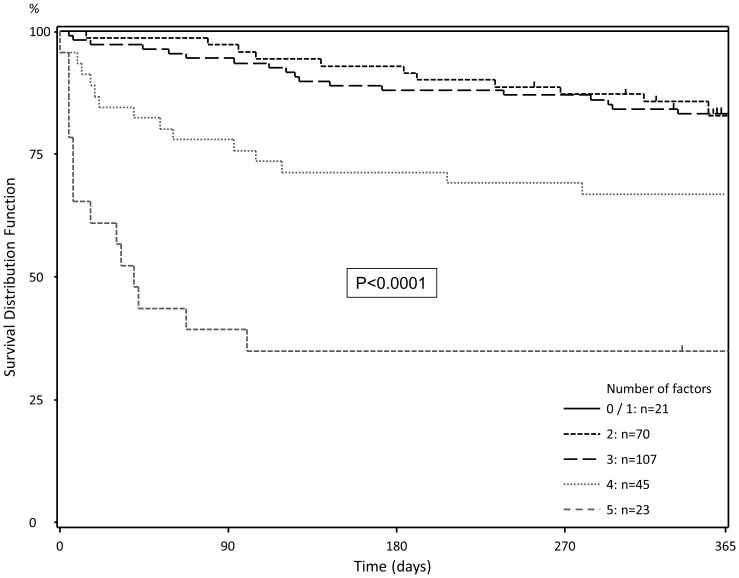
Survival stratified for number of positive risk factors.With an increasing number of risk-factors, postoperative 90-day and 1-year mortality increased (0–1: 0 and 0%; 2: 2.9 and 17.4%; 3: 5.6 and 16.8%; 4: 22.2 and 33.3%; 5: 60.9 and 66.2%).